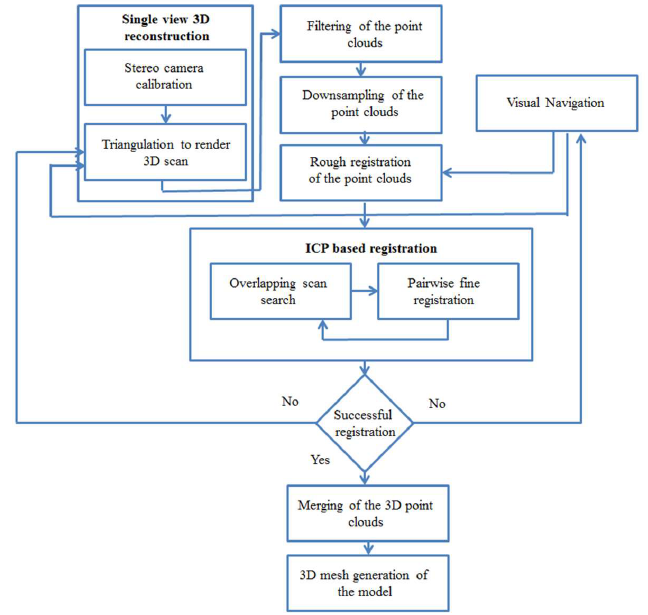
Figure 1. The block diagram of the proposed approach showing different algorithms.